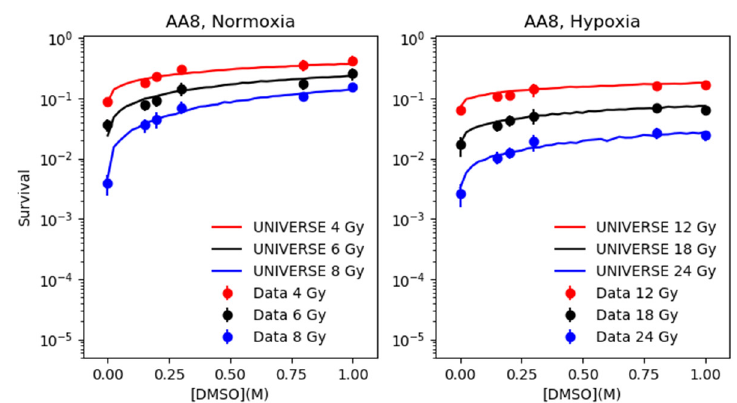
Figure 4. AA8 cell survival data (dots with error bars) in normoxia (left panel) and in hypoxia (right panel) as a function of DMSO concentration in units of M for different dose levels as shown in the legends, taken from Hirayama et al. [12], are compared against model predictions (lines).